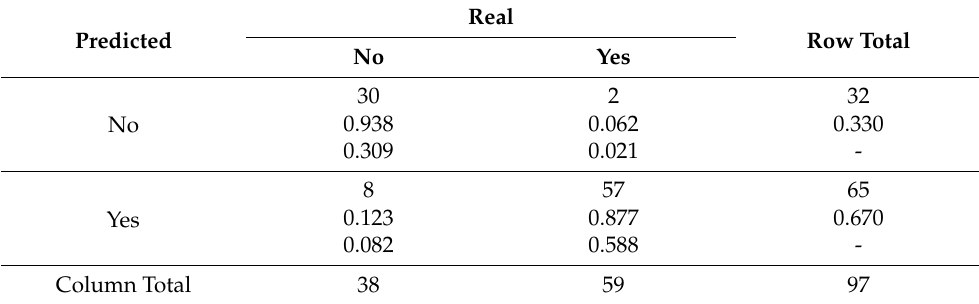
Table 1. Confusion matrix. Logistic regression model.